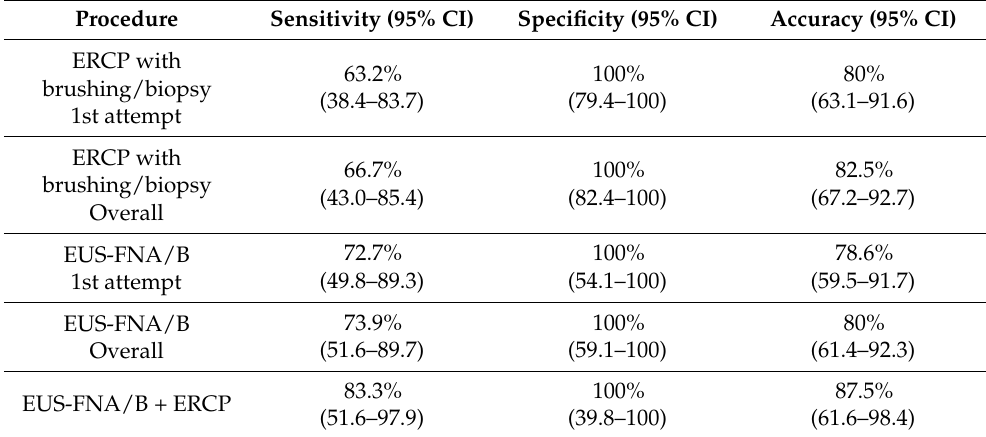
Table 2. Diagnostic yield of ERCP with brushing/biopsy and EUS-FNA/FNB in biliary